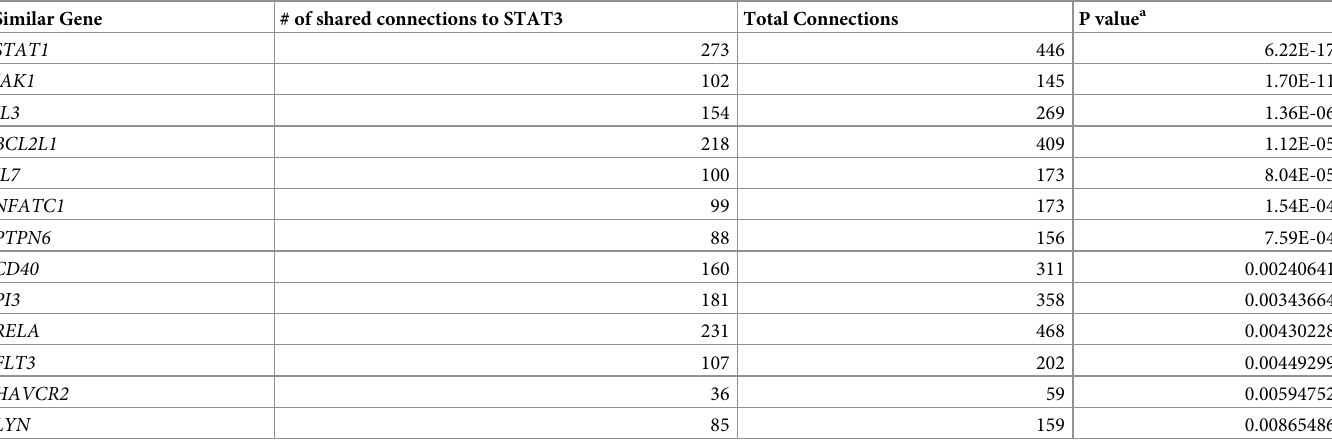
Table 5. Analysis of similar STAT3 matrix